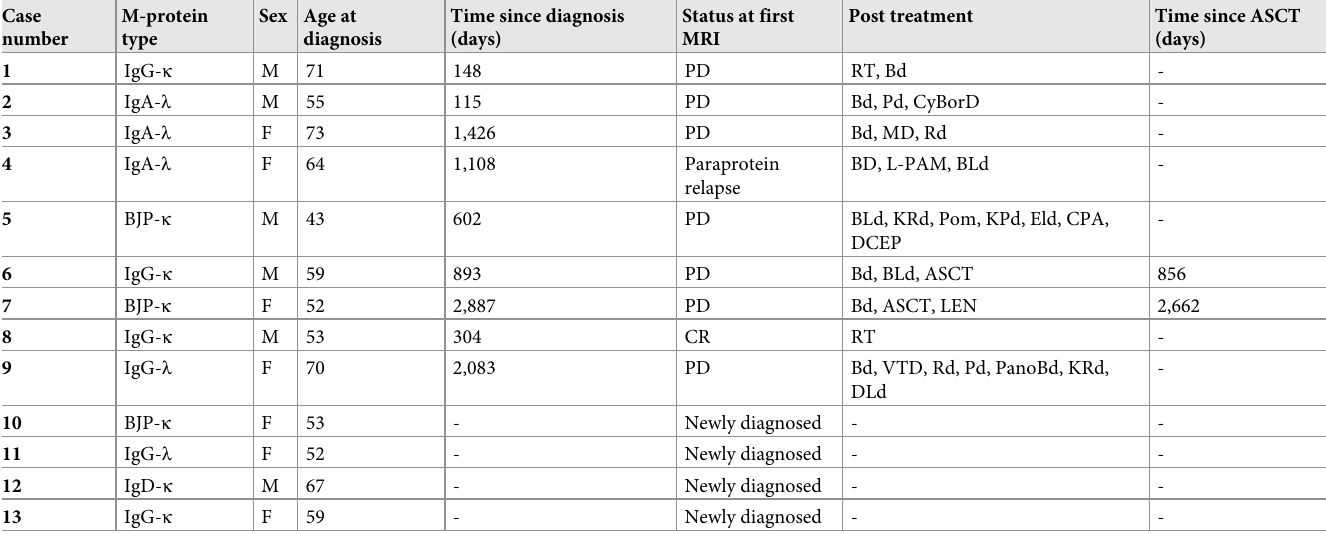
patients with MGUS. The tDV tended to be higher in patients with MM than in those with MGUS (Fig 2). In solid tumors, the ADC level tended to decrease with increase in tumor grade [27, 28]; however, this was not observed in MM and MGUS. Myeloma cell morphology and ADC Based on bone marrow aspiration performed at the same time as DWIBS-MRI, myeloma cell samples from 20 patients with newly diagnosed MM were classified and their ADC values were examined. The ADC values of intermediate and mature cell types were significantly Table 2. Treatment responses of patients who underwent diffusion-weighted imaging with body signal suppression magnetic resonance imaging (MRI) repeatedly. Case M-protein number